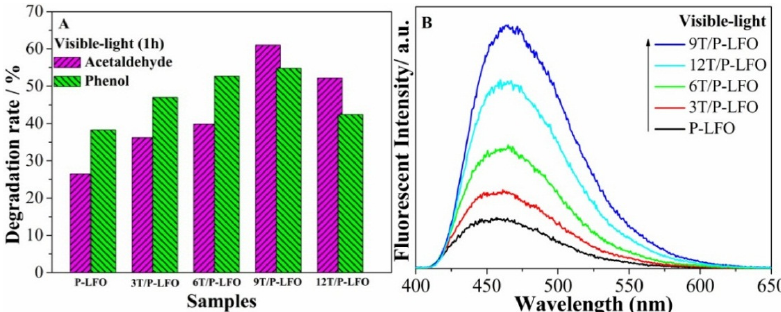
Figure 6. Visible-light photocatalytic activity for acetaldehyde and phenol degradation ( A ) and OH − radical amount related Fluorescence spectra ( B ) of P-LFO and T/P-LFO nanocomposites.